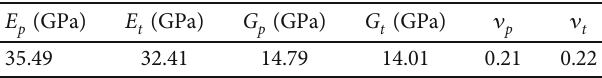
Figure 12: Stress-displacement relationship of an element subject to uniaxial tensile stress (at lower left) and uniaxial compressive stress (at upper right) [33]. Table 1: Elastic parameters of transversely isotropic shale.